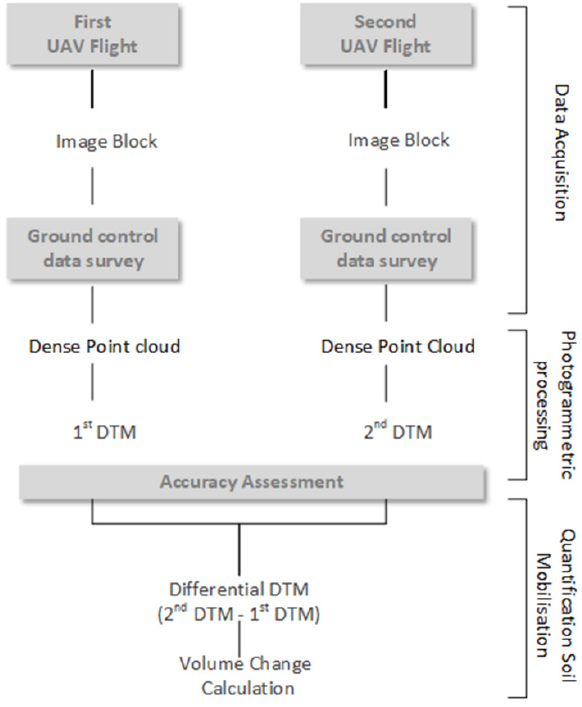
Figure 1. Methodology for the quantification of mobilised soil volume.